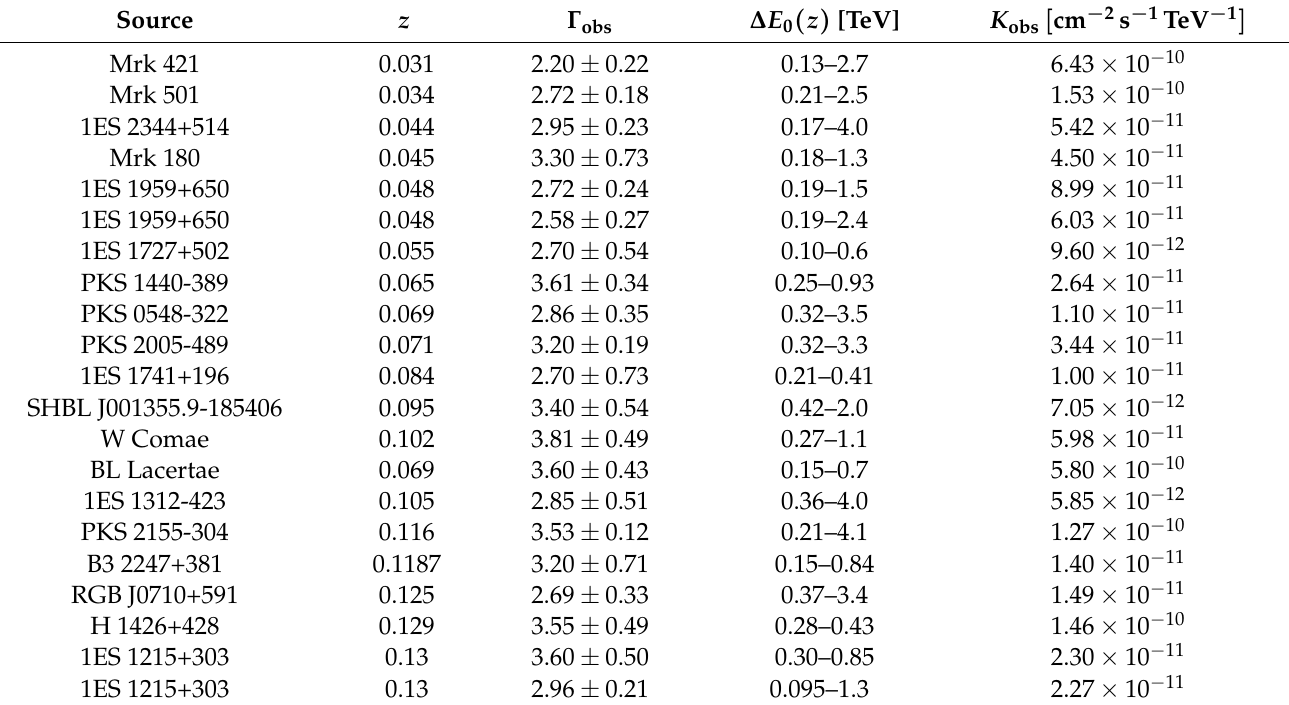
Table A1. Considered VHE blazars with redshift z , spectral slope Γ obs , energy range and normaliza- tion constant K obs . Statistical and systematic errors are added in quadrature to produce the total error reported on the measured spectral slope. When only statistical errors are quoted, systematic errors are taken to be 0.1 for H.E.S.S., 0.15 for VERITAS, and 0.2 for